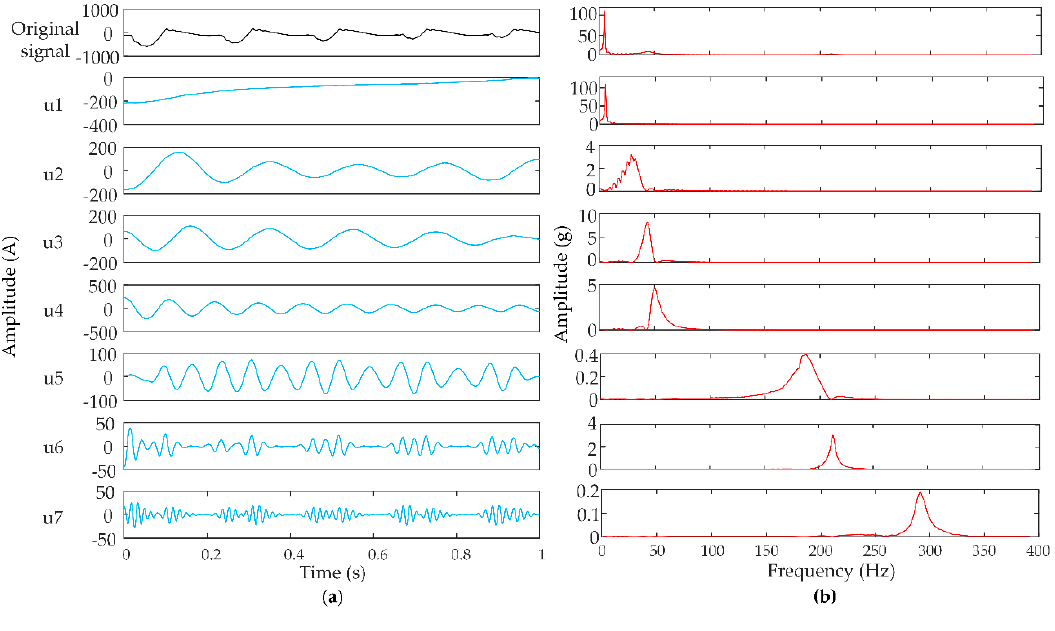
Figure 7. Results and spectra of VMD for transformer inrush disturbance: ( a ) Modes; ( b ) Frequency spectra.